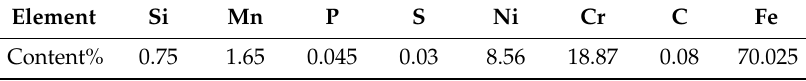
Table 3. Chemical composition of AISI 304 stainless steel.